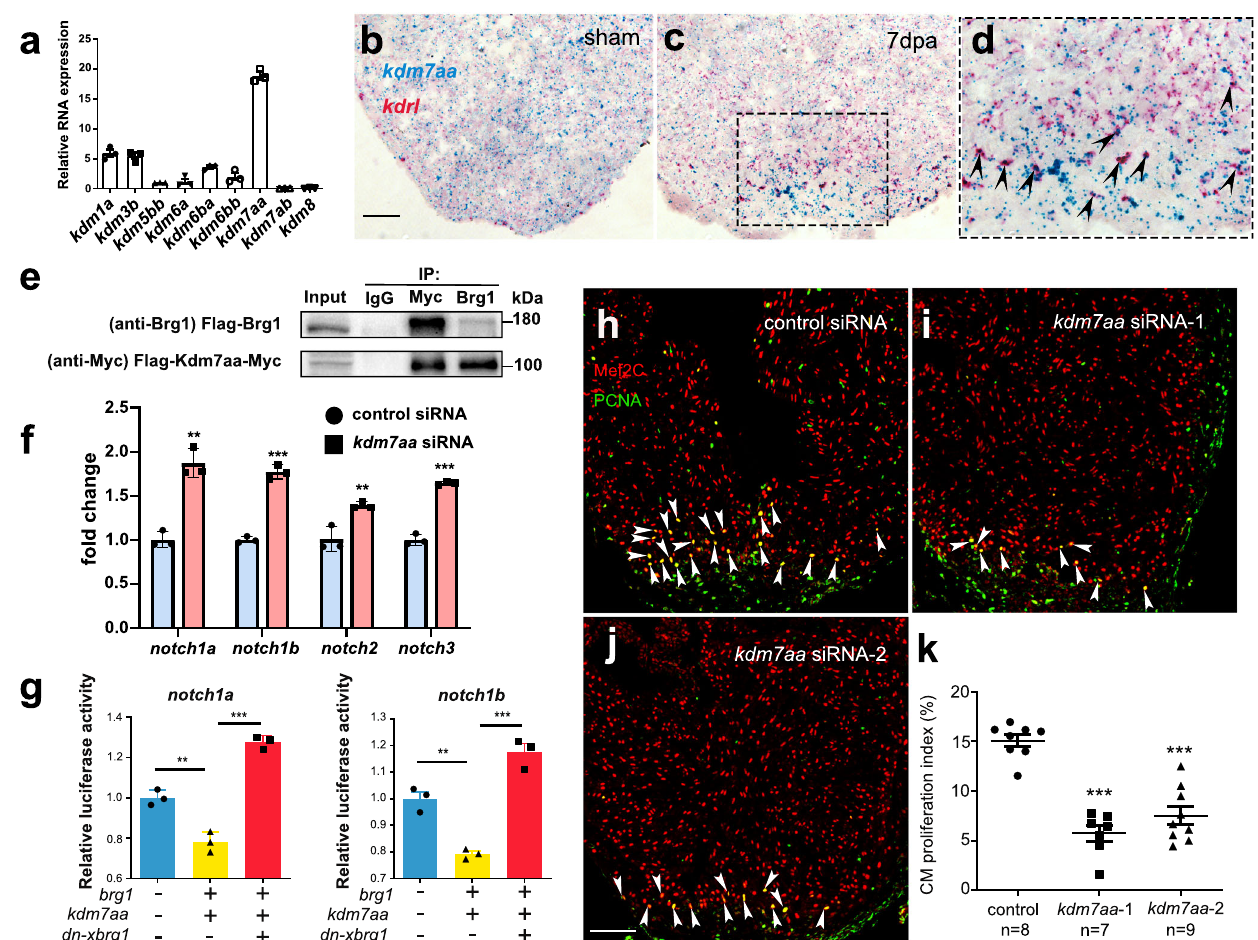
Fig. 5 Endothelial Brg1 regulates notch receptor expression and myocardial proliferation via interaction with Kdm7aa. a Quantitative RT- PCR of kdm genes expression, normalized by gapdh . b – d Representative images of RNAscope in situ hybridization with kdrl and kdm7aa probes (scale bar, 100 μ m) and high-magni fi cation image of boxed region in ( c ) (arrowheads, double kdrl - and kdm7aa -positive endothelial cells). e Immunoprecipitation (IP) assays with either anti-Myc or anti-Brg1 antibody in 293T cells. Inputs were used as loading controls and IgG as negative controls. The blots were derived from the same experiment, and they were processed in parallel. f Quantitative RT-PCR analysis showing that the expression levels of notch1a , notch1b , notch2 , and notch3 from hearts at 7 dpa injected with encapsulated kdm7aa siRNA was higher compared with the control siRNA group. Data represented one of three independent experiments. Data were mean fold changes ± s.e.m., *** p < 0.005, unpaired t -test. g Luciferase reporter assays in 293T cells stably expressing the notch promoter-luciferase reporter in the pGL4.26 vector. Expression plasmid clones containing kdm7aa , brg1 , or dn-xbrg1 were co-transfected into cells stably expressing each notch reporter. Data represented one of two independent experiments, *** p < 0.005, one-way analysis of variance ( F = 110.6 for the left panel and 60.3 for the right panel) followed by the Bonferroni test. n number shown here ( f and g ) indicated technical replicates. h – j Representative images of immunostaining showing the numbers of Mef2C + /PCNA + proliferating cardiomyocytes (arrowheads, Mef2C + / PCNA + proliferating cardiomyocytes; scale bar, 100 μ m). k Statistics of panels ( h – k ) ( n numbers indicated biological replicates; data were the mean ± s.e.m.; *** p < 0.005; one-way analysis of variance [ F = 36.79] followed by Dunnett ’ s multiple comparison